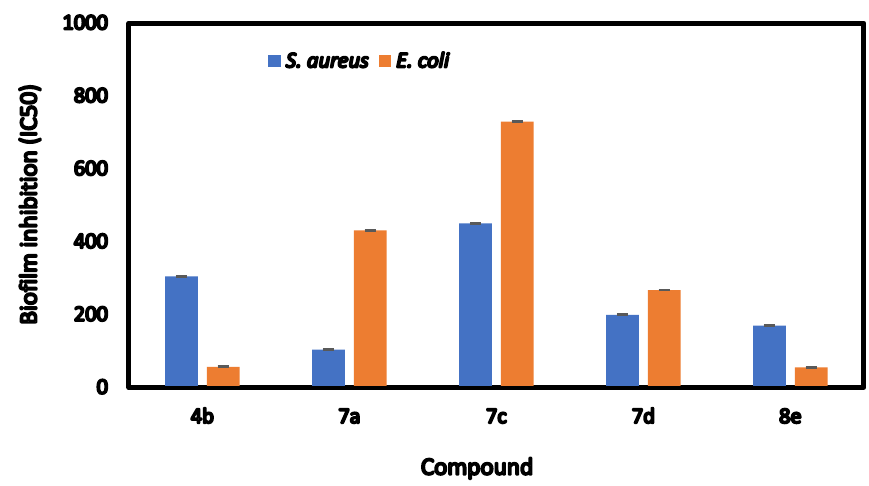
Figure 4. Antibiofilm formation (IC 50 , µ g/mL) of the most active selected compounds against Staphylococcus aureus (blue), and Escherichia coli (orange). Values are expressed as means ± SE; n = 3 for each group.